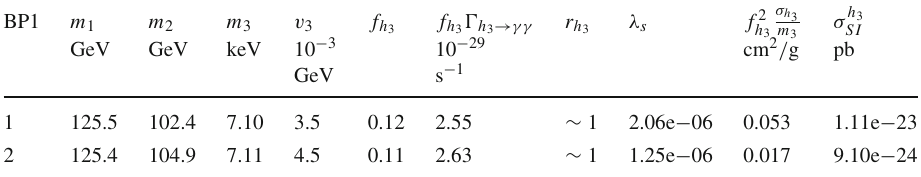
Table 4 Calculations of different observables for the scalar dark matter candidate for the same set of benchmark points given in Table